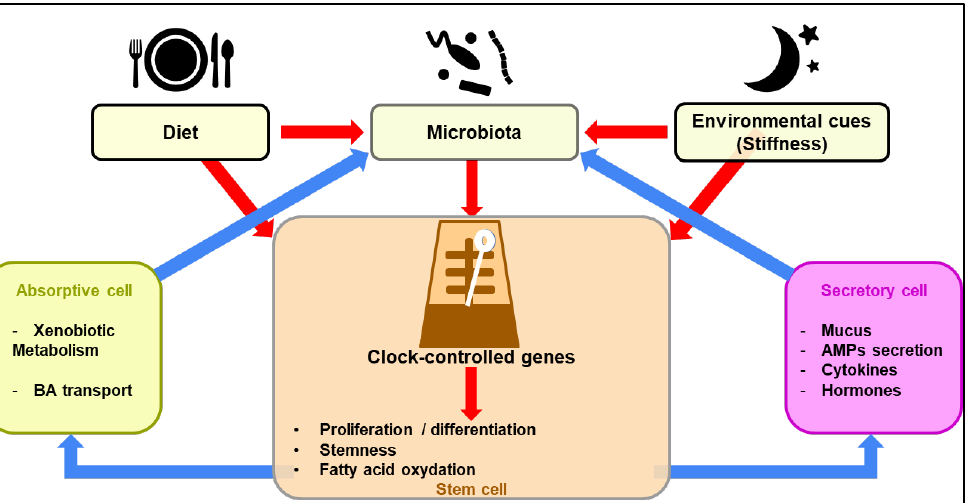
Figure 1. Diagrammatic overview of the regulation of clock-controlled function of intestinal epithelial cells upon sensing of environmental cues. Diurnal fluctuations in the gut microbiota composition may regulate the ability of stem cells to proliferate and differentiate through a complex metabolic reprogramming (red arrows). This leads to a concerted action by intestinal epithelial cells on the gut microbiota through both positive and negative feedback loops (blue arrows).